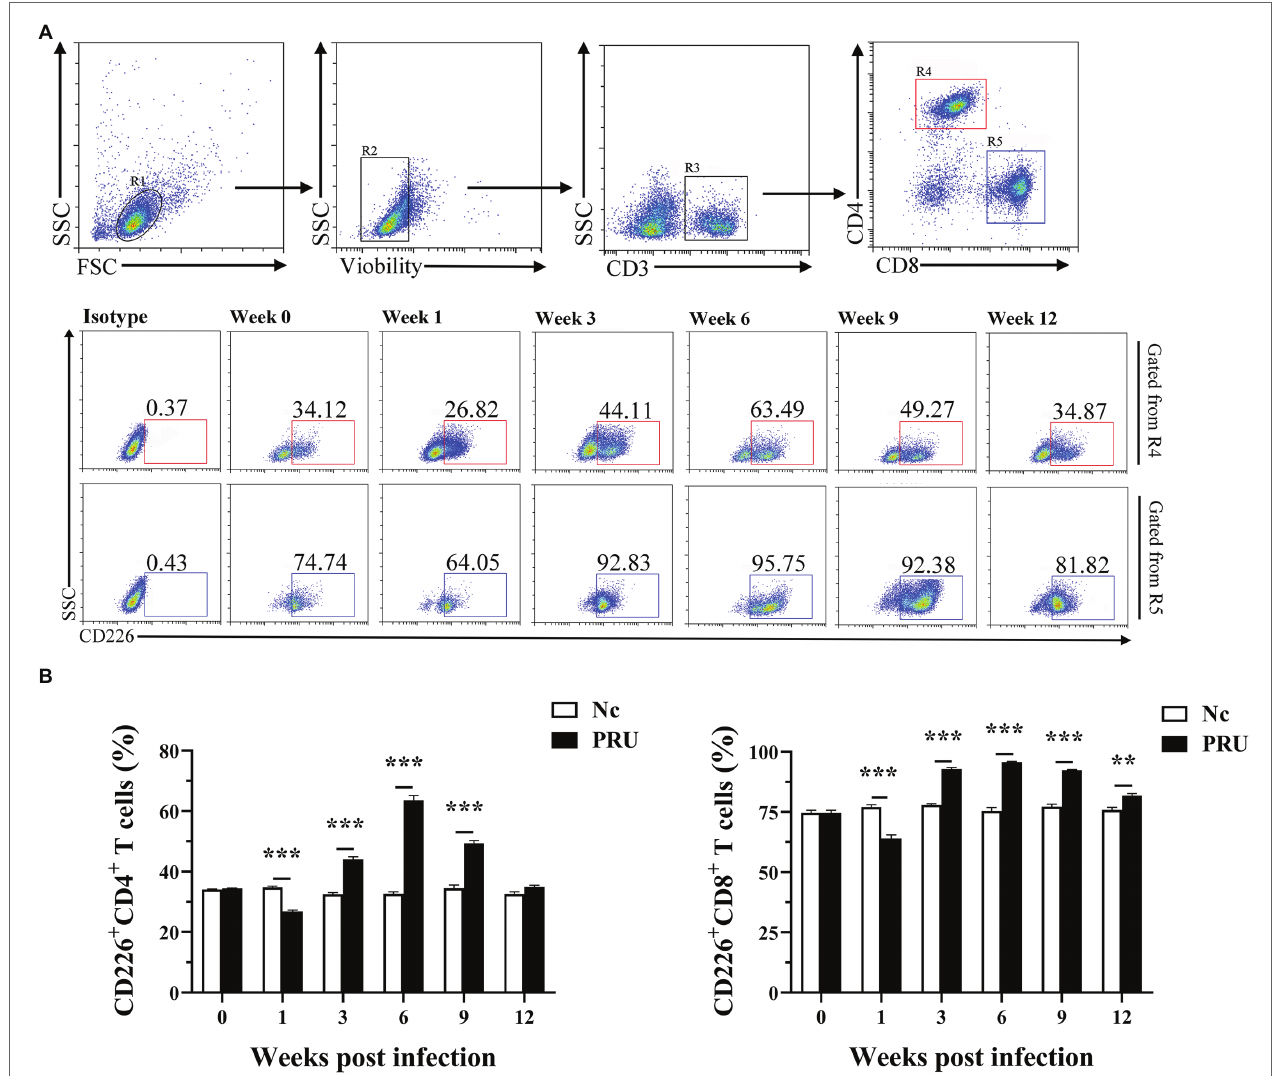
FIGURE 3 | Changes in CD226 expression on T cells in spleen after T. gondii infection. (A) Proportions of CD226 + cells among CD4 + and CD8 + T cells in T. gondii - infected (PRU) and normal mice (Nc) after infection. (B) Dynamic changes in the percentages of CD226 + T cells at different time points. The results are representative of three independent experiments with five mice in each group per experiment, with data denoting means ± SDs. ** p < 0.01 and *** p < 0.001 (compared to the